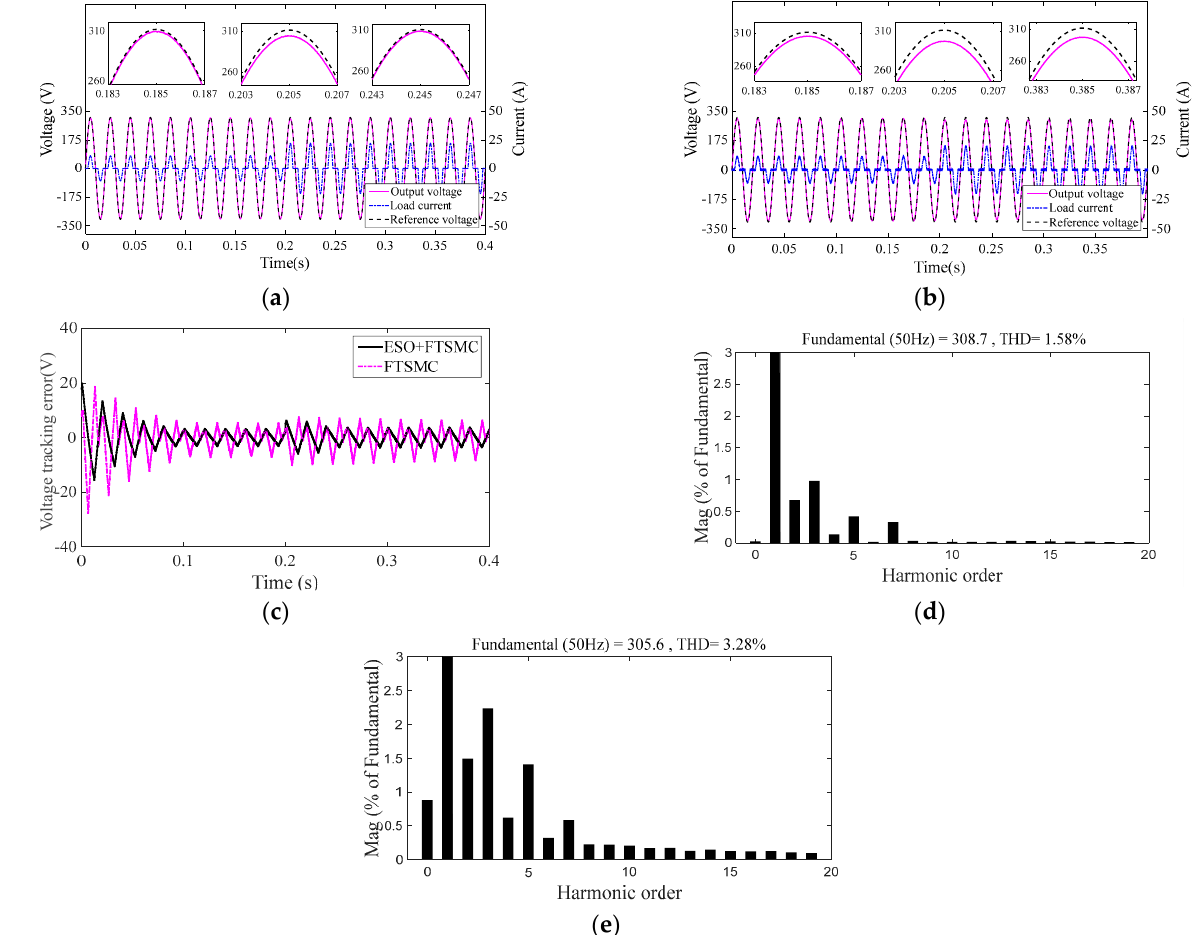
Figure 6. Inverter system output response under nonlinear load saltation: ( a ) output response of System 1, ( b ) output response of System 2, ( c ) voltage error, ( d ) output voltage THD of System 1, and ( e ) output voltage THD of System 2.